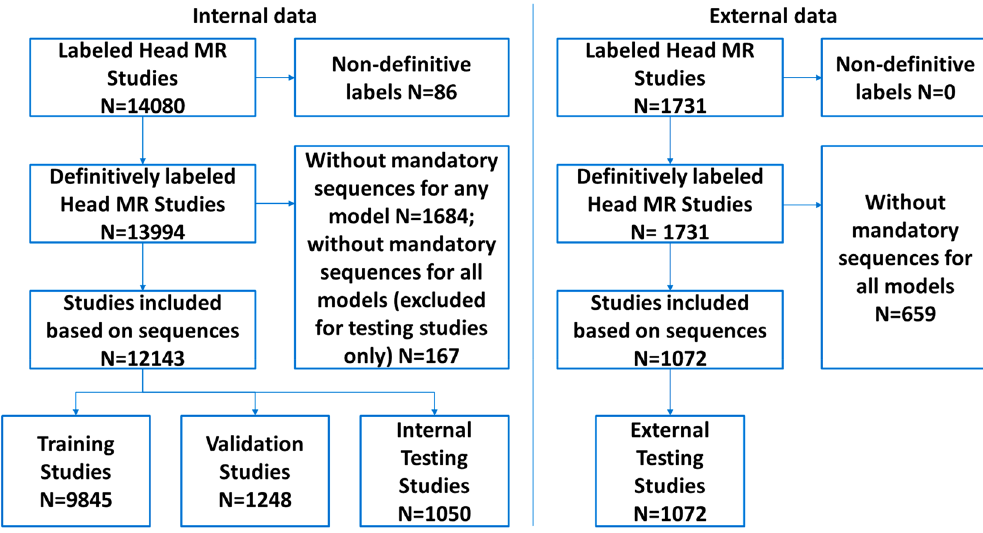
Figure 1. Study flowchart. Non-definitive labels denote reports where the neuroradiologists deemed that classifying the study as positive or negative for one or more of the labels would be acceptable.